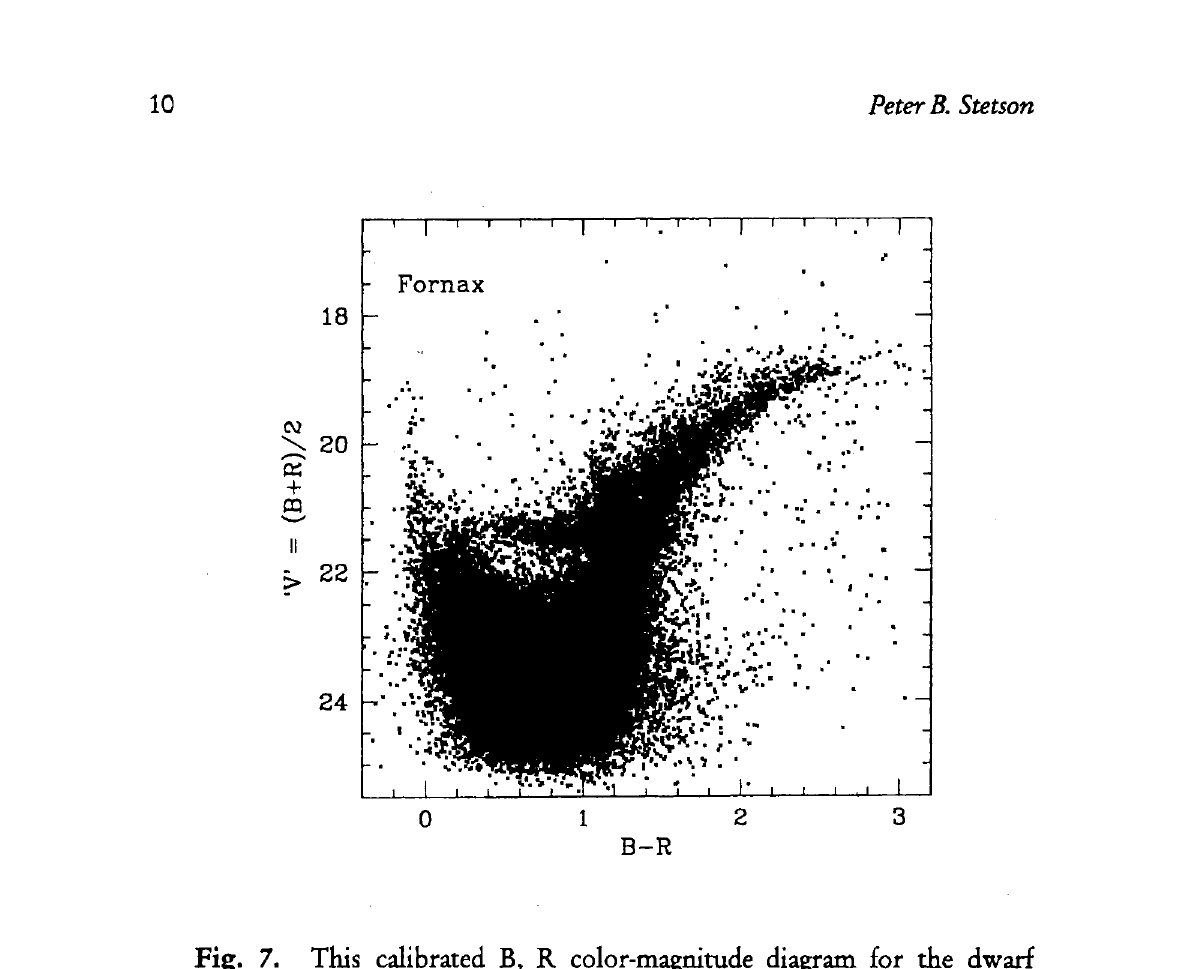
Fig. 7. This calibrated B, R color-magnitude diagram for the dwarf spheroidal galaxy in Fornax was derived by Tammy Smecker-Hane from observations that she made in collaboration with Jim Hesser, Doug Geisler and me, at the prime focus of the CTIO 4 m telescope. This galaxy, too, shows that star formation took place from 13 - 15 Gyr to only a few Gyr ago. Unlike Carina, Fornax shows no evidence for distinct bursts of star formation; instead, stars appear to have formed more or less continuously over the whole